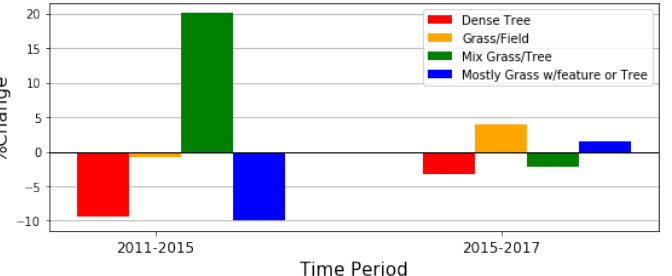
Figure 5. Percentage of the change in each cluster in CoMo area during the time periods 2011–2015 and 2015–2017. In 2011–2015 change detection, we see much dense tree giving way to a lot of Mixed Grass/Tree. This may be characteristic of upper scale sparse residential build up in previous forest-like areas. The changes are lower-scale from 2015 to 2017 that is in part due to the 2-yr vs. 4-yr comparison, but also represents that different characteristics changes are